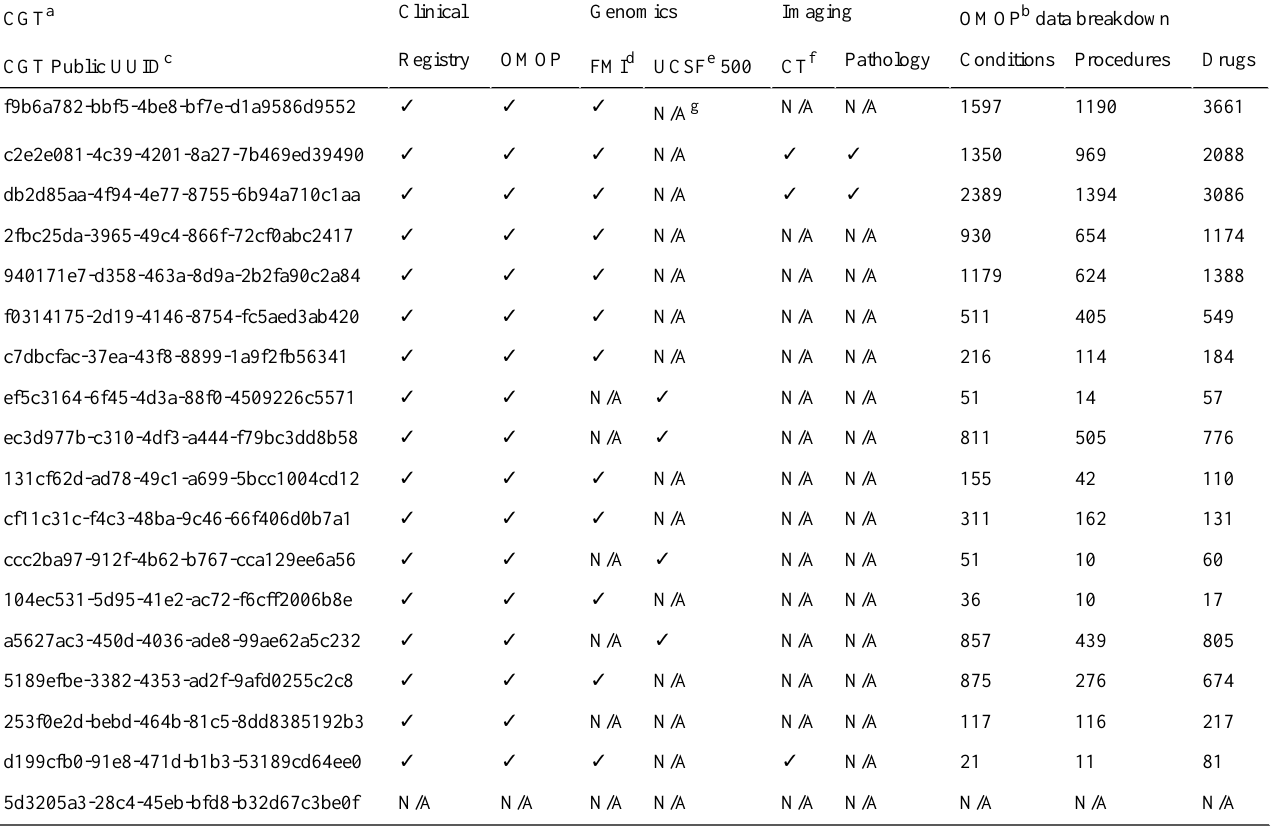
Table 3. Breakdown of Cancer Gene Trust data by patient and